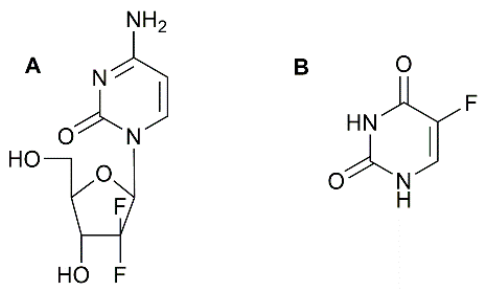
Figure 1. Chemical structure of ( A ) gemcitabine and ( B ) 5-fluorouracil.